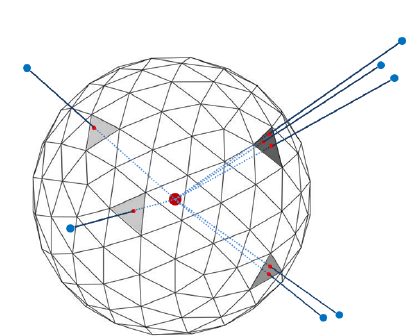
Figure 1. Geodesic tessellation of spherical surface and projection of neighboring points onto the corresponding grid. The large red dot in the middle of the sphere indicates the target 3D point to be classified into a semantic label. The blue dots indicate neighboring 3D points, which are projected onto the geodesic grid (small red